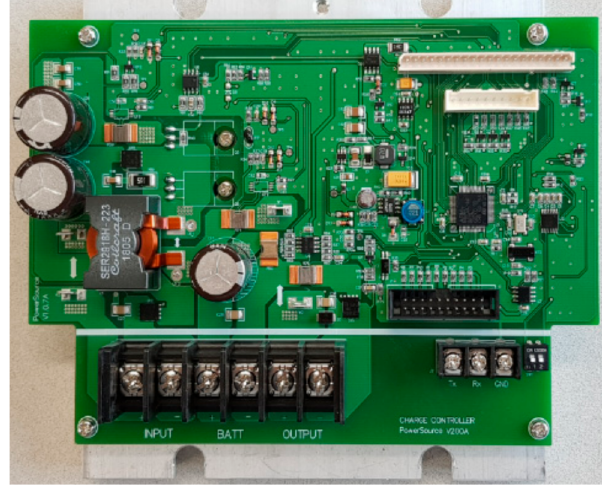
Figure 7. MPPT PCB